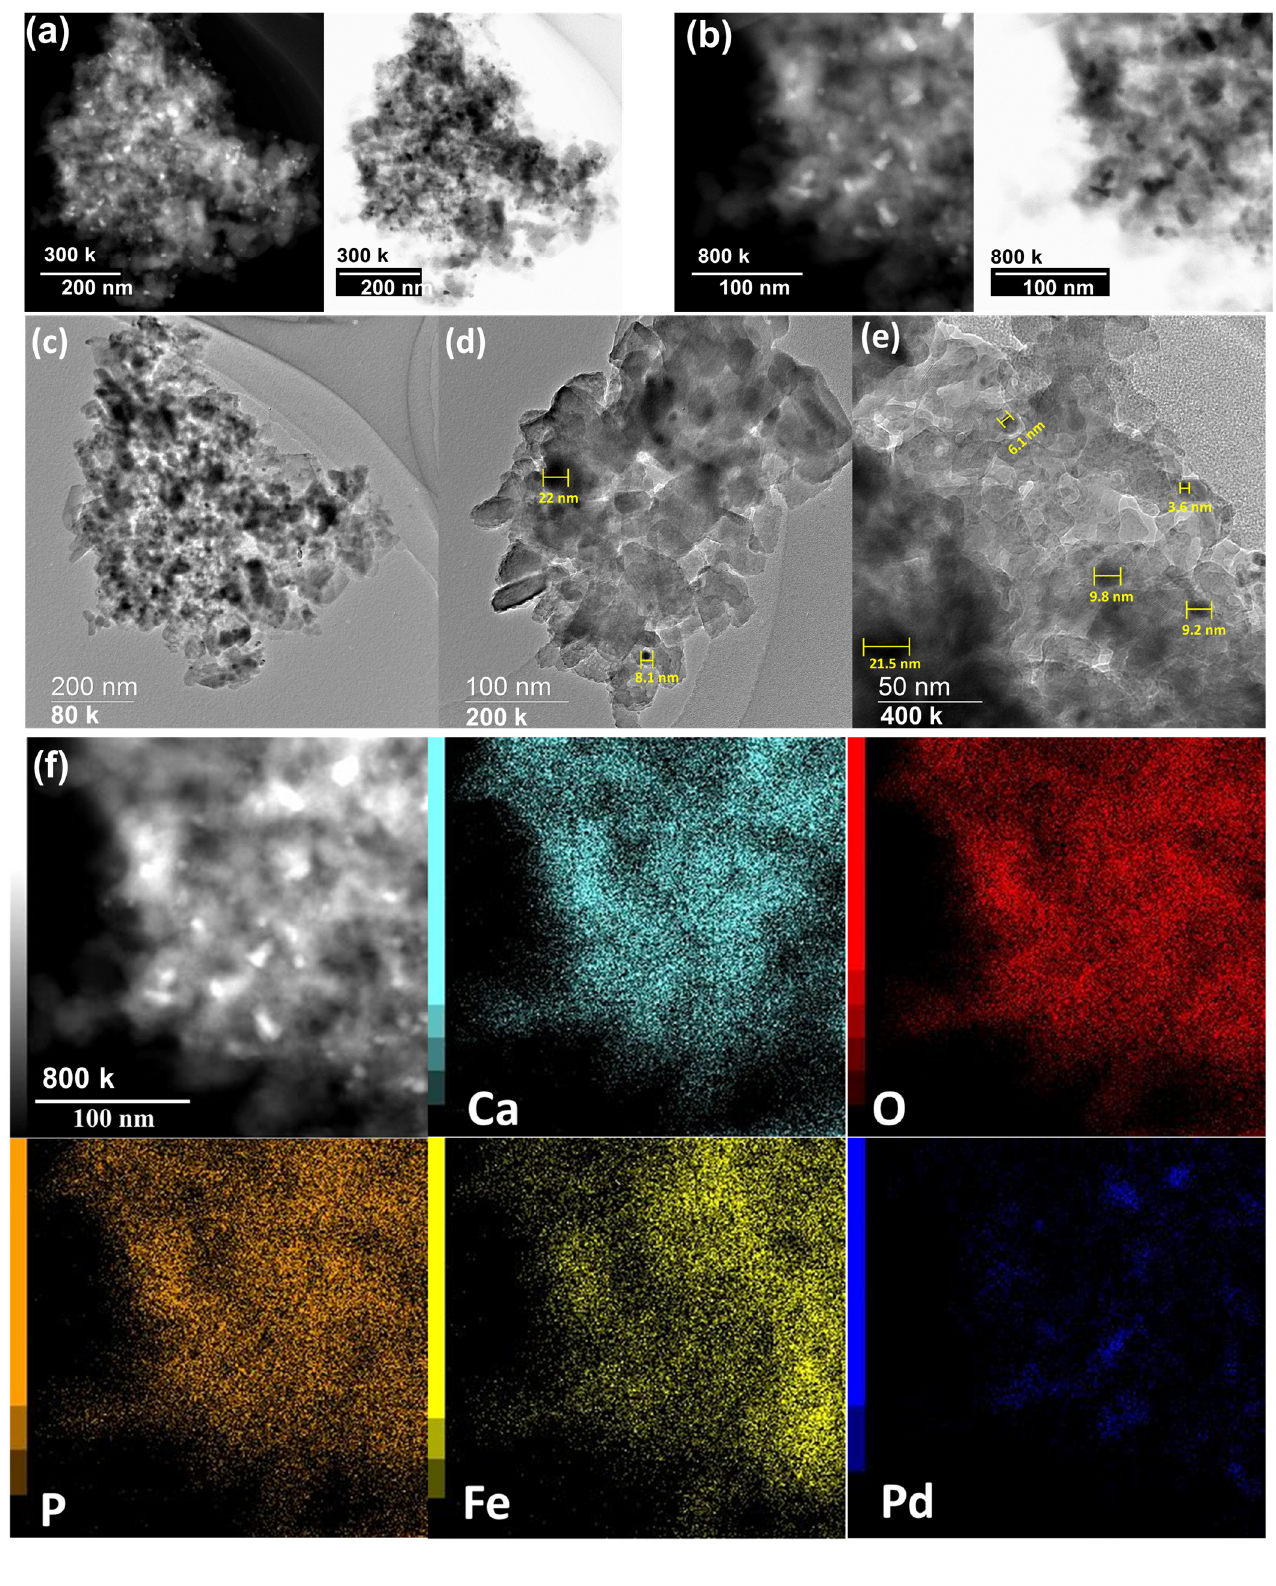
Figure 4. STEM images (right = dark filed, left = bright filed) of Pd@FeHAp with magnification